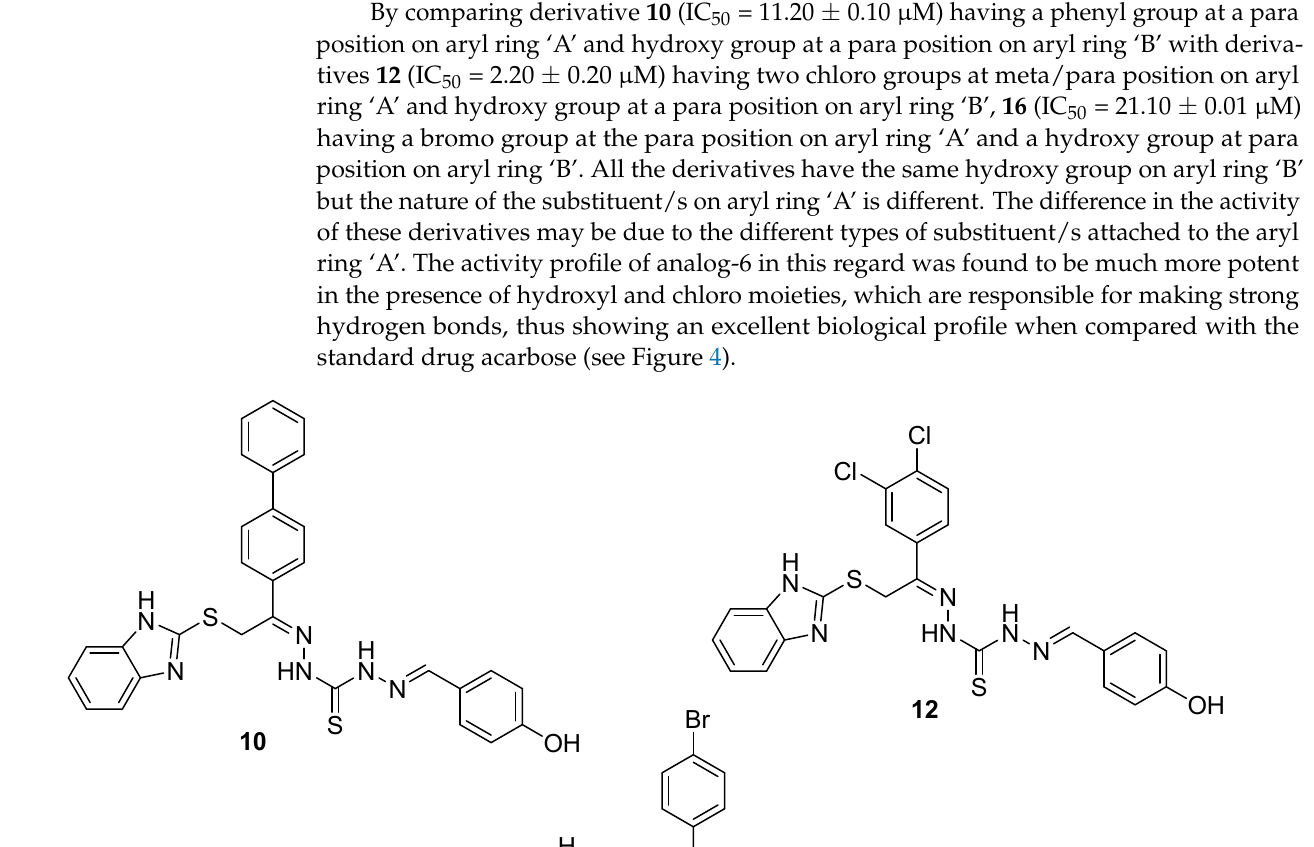
Figure 5. Structure–activity relationship of derivatives 19 and 20 . 2.3. In Vitro α -amylase Activity All the synthesized derivatives were also evaluated against the α -amylase enzyme and showed excellent activity, having an IC 50 value in the range of 1.10 ± 0.20 to 21.10 ± 0.01 µM as compared to the reference drug acarbose (IC 50 = 11.12 ± 0.15 µM). By comparing derivative 11 (IC 50 = 3.10 ± 0.10 µM) with 12 (IC 50 = 1.10 ± 0.20 µM), 13 (IC 50 = 2.10 ± 0.10 µM), and 14 (IC 50 = 6.10 ± 0.20 µM). The entire derivative has two chloro groups at the meta and para positions on the aryl ring ‘A’ but the substituent on aryl ring ‘B’ is different. In derivatives 11, 13, and 14 , there is a nitro group at different positions on aryl ring ‘B’, while in derivative 12, there is a hydroxy group on aryl ring ‘B’. The differ- ence in the potentials of these derivatives may be due to the different nature and position of the substituent on aryl ring ‘B’ (see Figure 6).